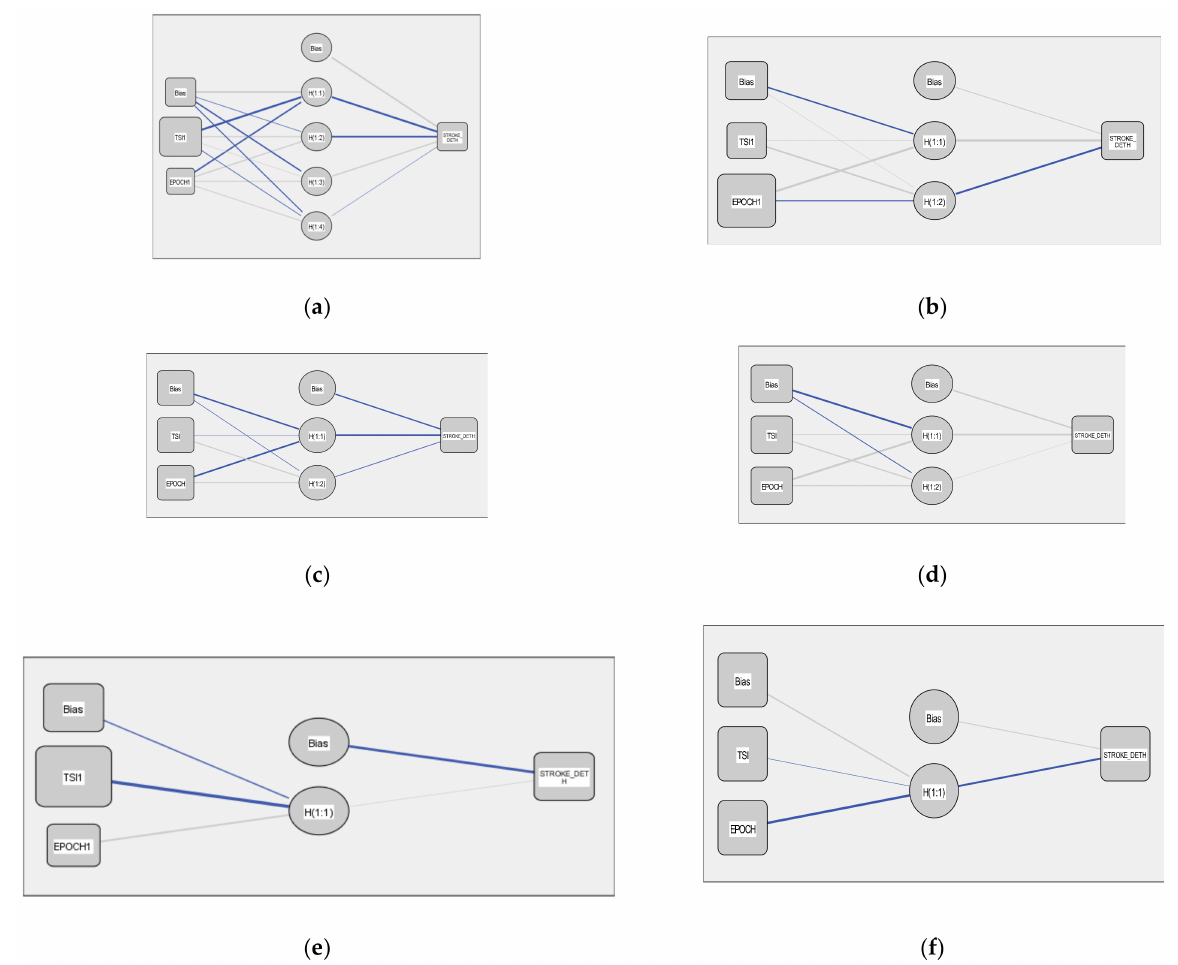
Figure 2. Created neural networks: ( a ) 1985; ( b ) 1986; ( c ) 1987; ( d ) 1988; ( e ) 1989; ( f ) whole quinquen- nium. All six networks have one hidden layer. The dependent variable in every network is stroke death and the independent variables are TSI and